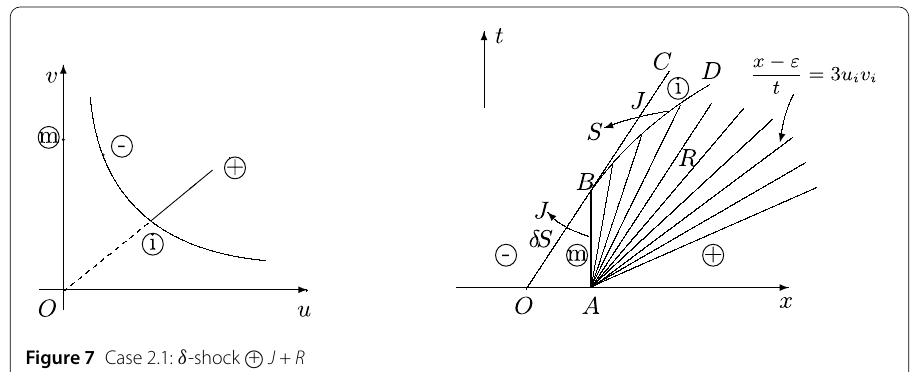
Figure 7 Case 2.1: δ -shock + (cid:10) J +